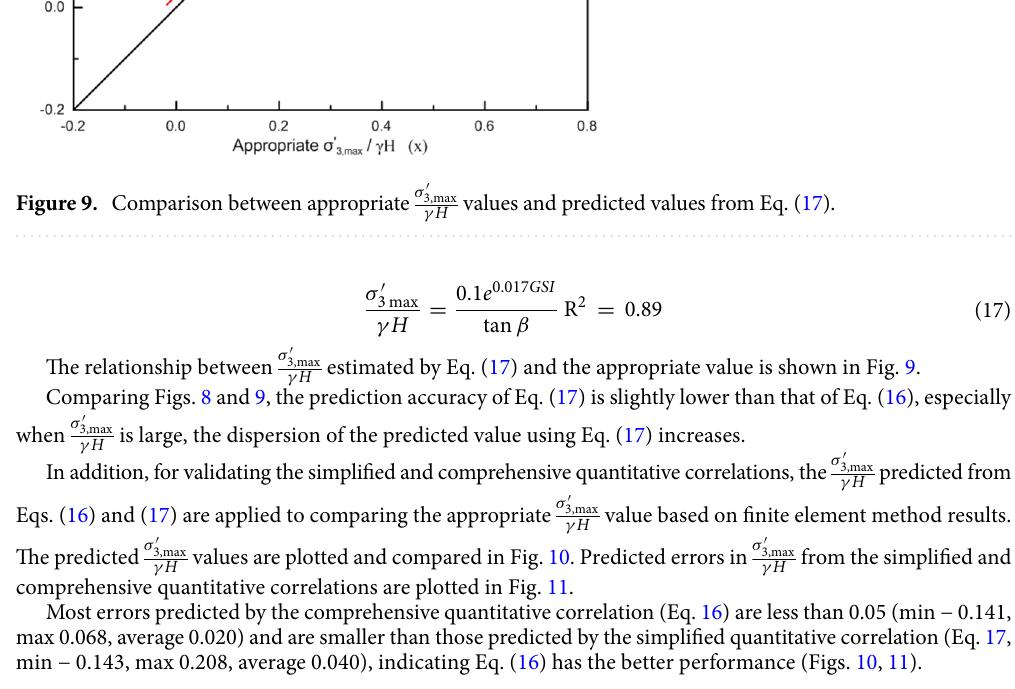
Figure 9. Comparison between appropriate